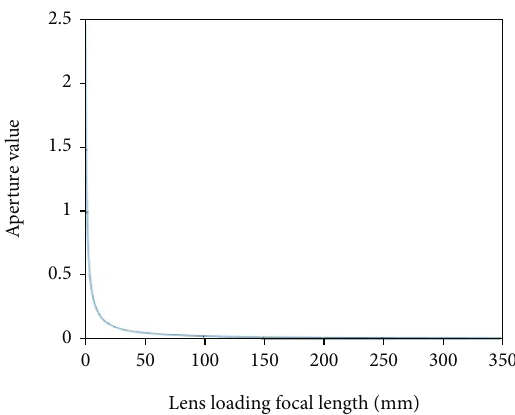
Figure 10: Variation curve of optical 11 range di ff erence δ versus mask focal length f